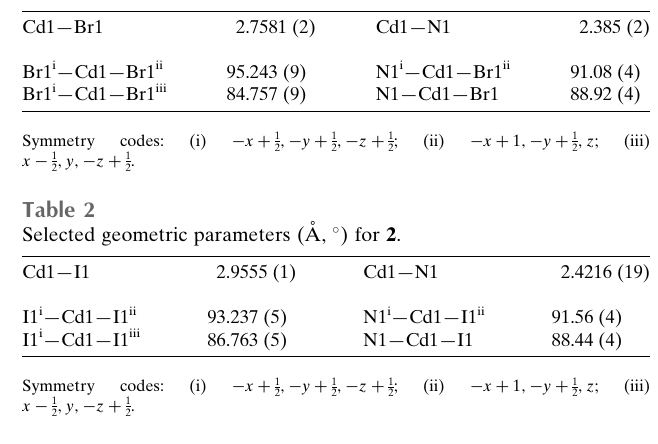
Table 1 Selected geometric parameters (A˚ , (cid:4) ) for 1 .